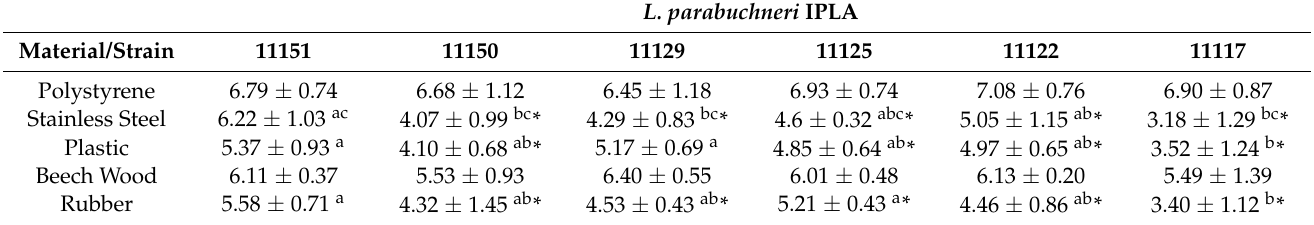
Table 2. Viable cells of L. parabuchneri strains adhered to surface material coupons after 48 h of incubation at 37 ◦